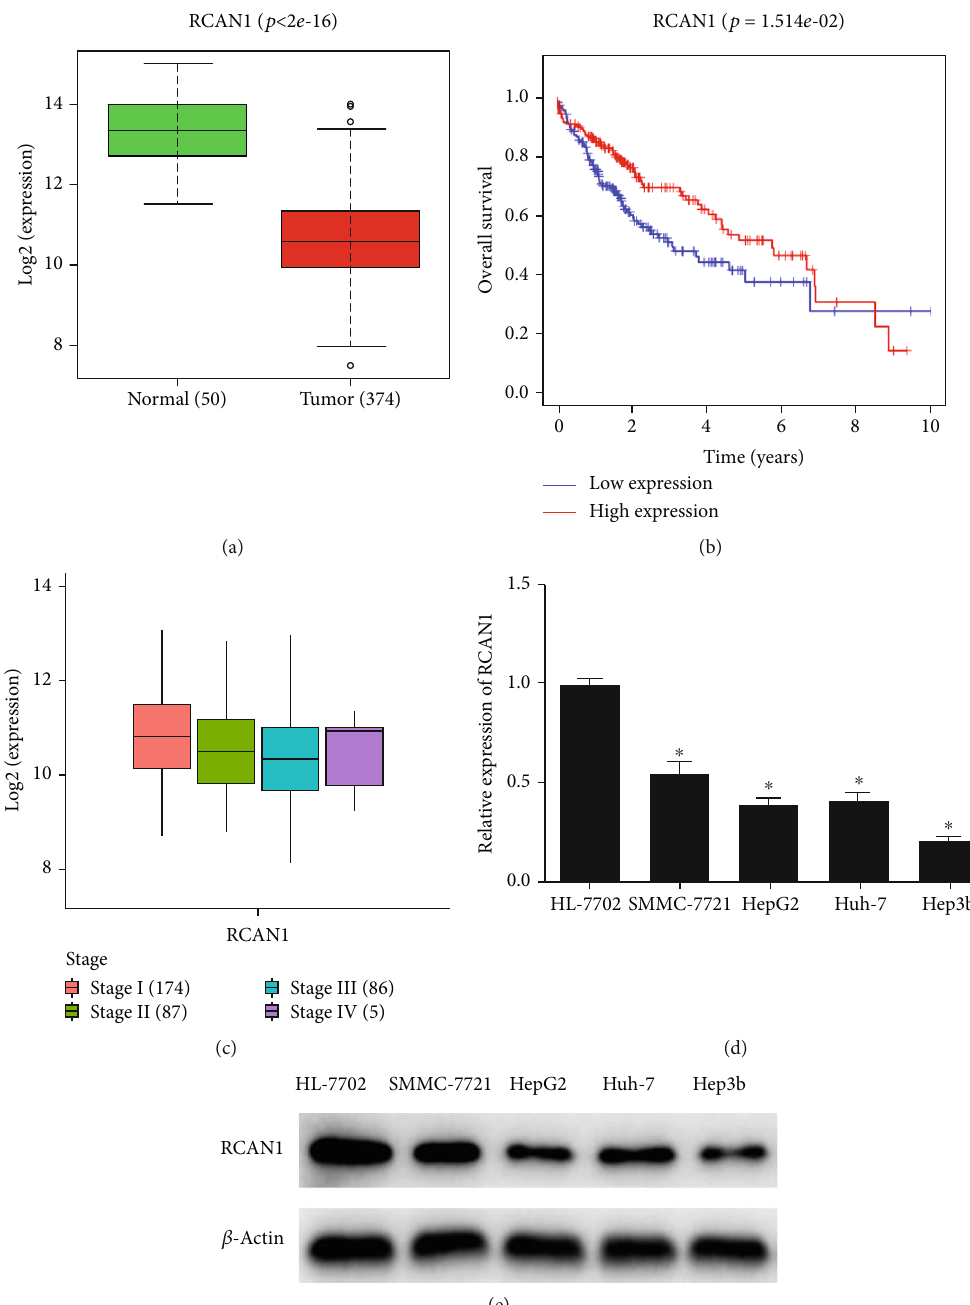
Figure 1: RCAN1 is signi fi cantly lowly expressed in liver cancer cells. (a) Relative expression of RCAN1 in normal group and tumor group in TCGA (the green represents normal group, the red represents tumor group); (b) survival curves of patients based on the expression of RCAN1 (the red line represents high expression group, the blue line represents low expression group); (c) correlation analysis of RCAN1 expression and clinical stage; (d) the expression levels of RCAN1 in human normal liver cell line HL-7702 and liver cancer cell lines SMMC-7721, HepG2, Huh-7, and Hep3b were detected by qRT-PCR; (e) RCAN1 protein levels in human normal liver cell line HL-7702 and liver cancer cell lines SMMC-7721, HepG2, Huh-7, and Hep3b were detected by western blot; ∗ p < 0 : 05